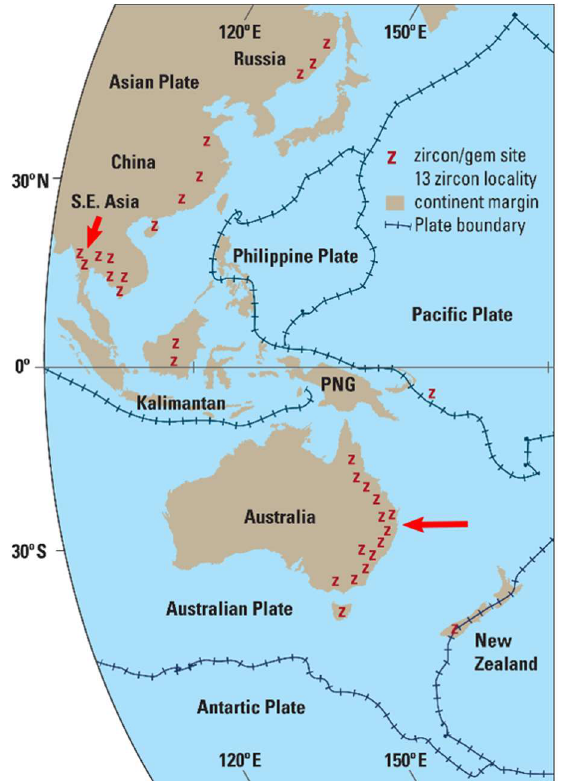
Figure 1. Regional setting and location of Myanmar and East Australian gem deposits, within the West Pacific continental margin zircon-corundum gem deposit zones (z), along the Asian and Australian plates [23,24]. Mogok and Mong Hsu, Myanmar, deposits (short arrow) are the western most sites [26] and New South Wales deposits (long arrow are among the eastern most group [9].